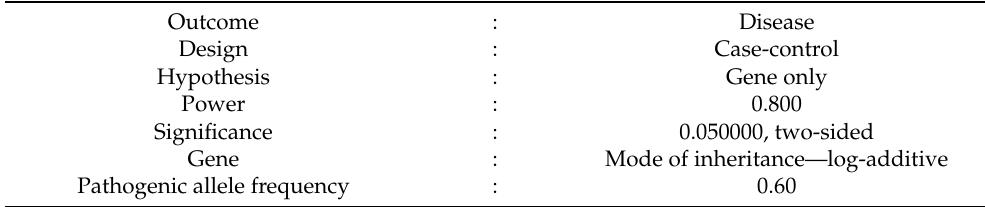
Table 1. Sample size